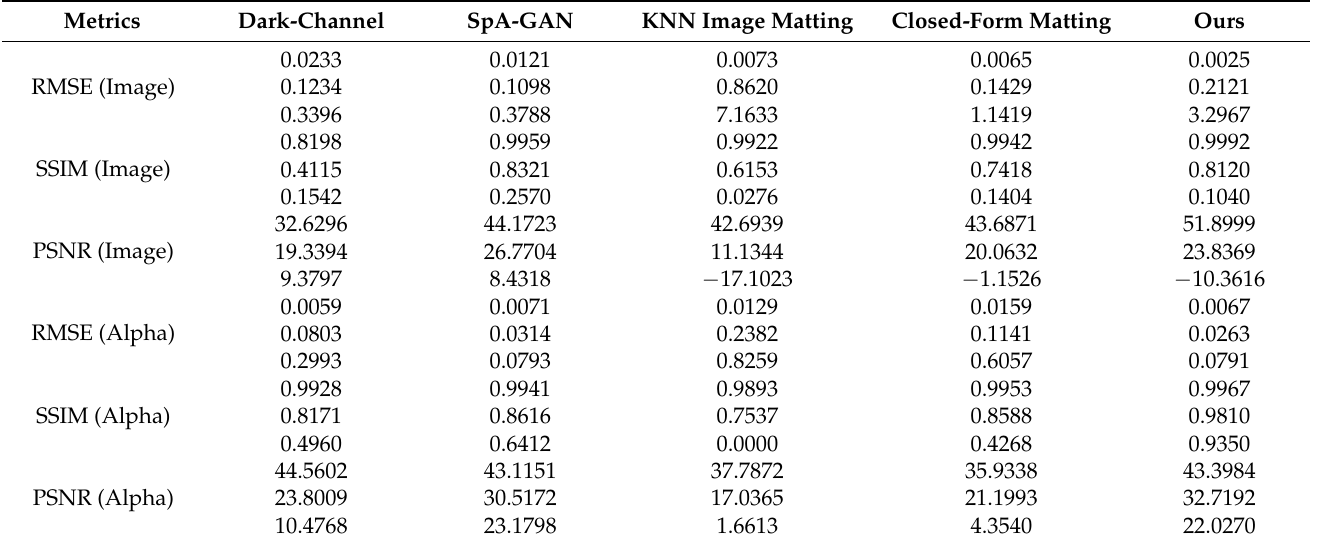
Table 2. Comparison of five cloud removal methods. The optimal value, average value, and worst value of the cloud removal result are represented by green, blue, and red,